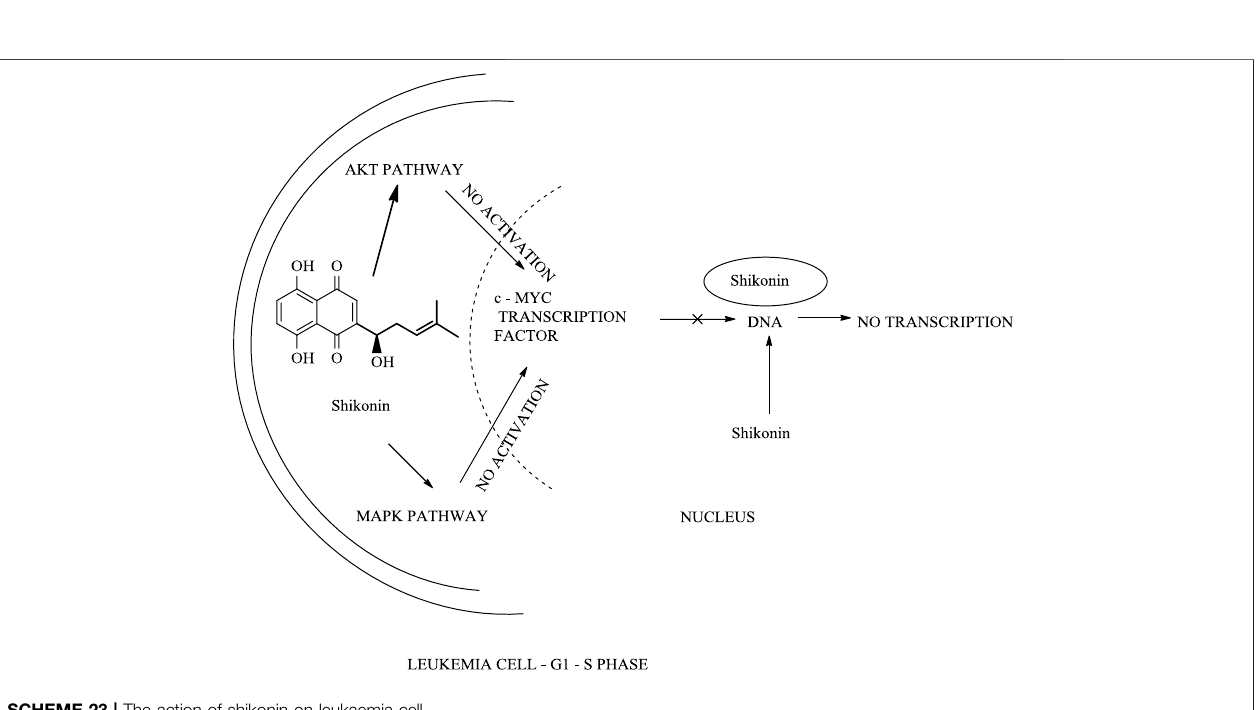
SCHEME 23 | The action of shikonin on leukaemia